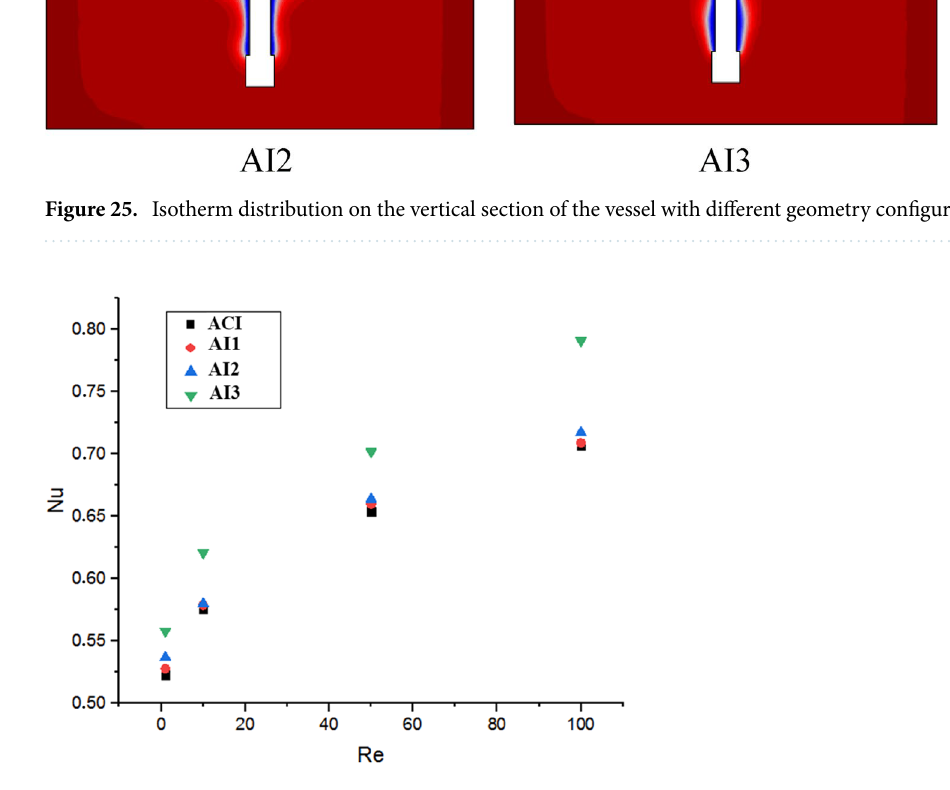
Figure 26. Nusselt number versus Reynolds number for different geometry